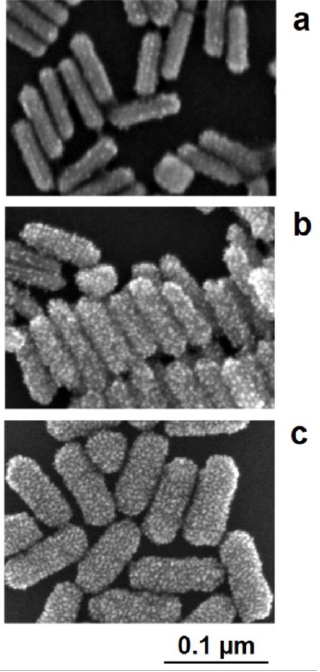
Figure 10. Interplay between the lattice-controlled and accidental nucleation of platinum on gold